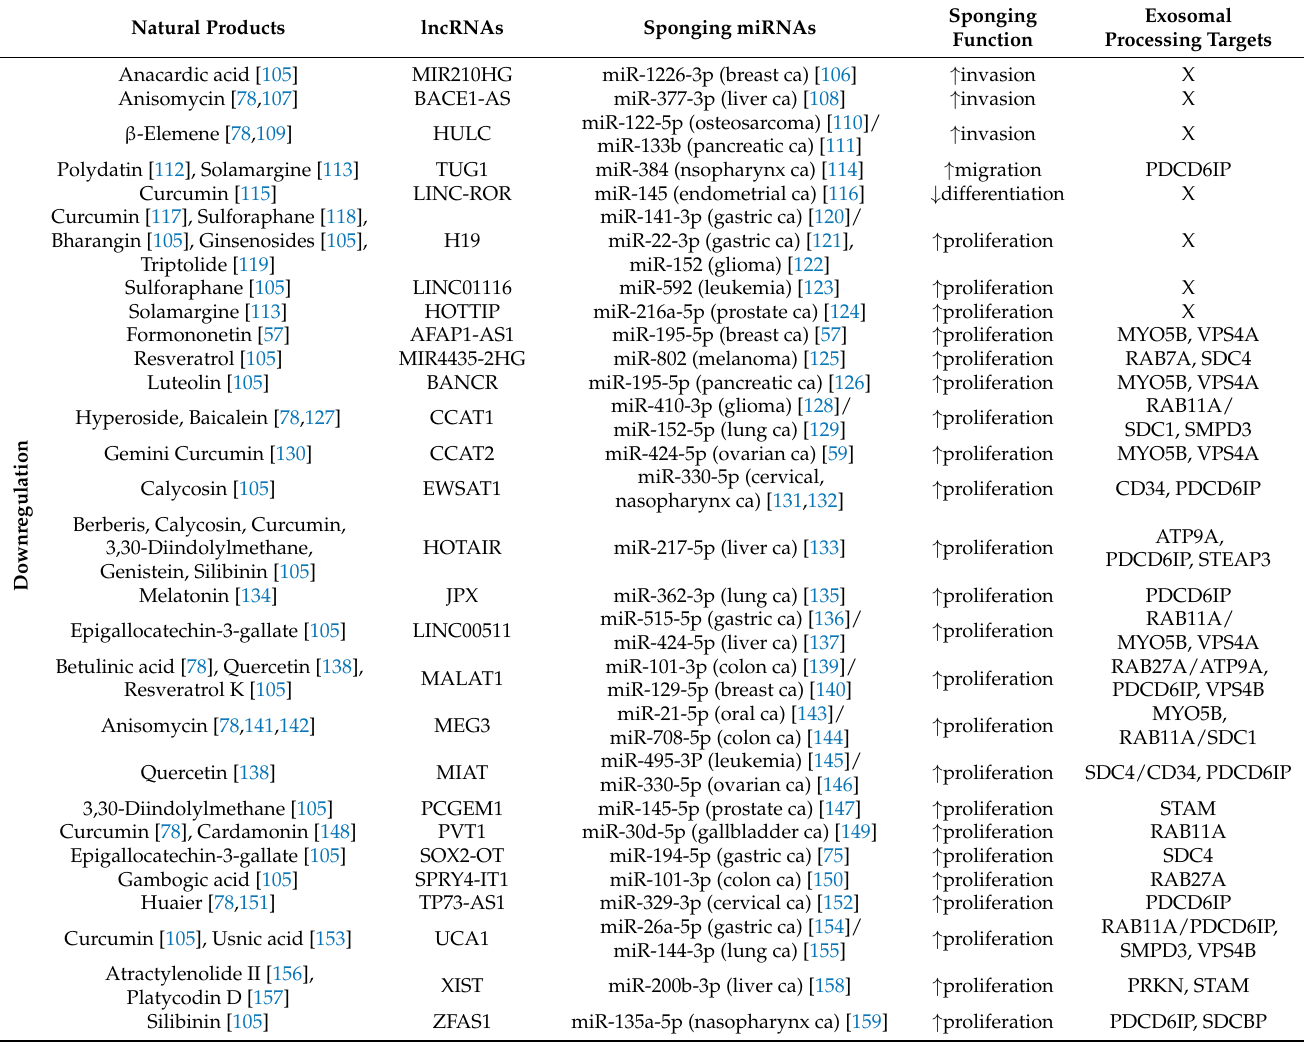
Table 3. Predicted sponging miRNAs and exosomal processing targets for natural-product- modulated